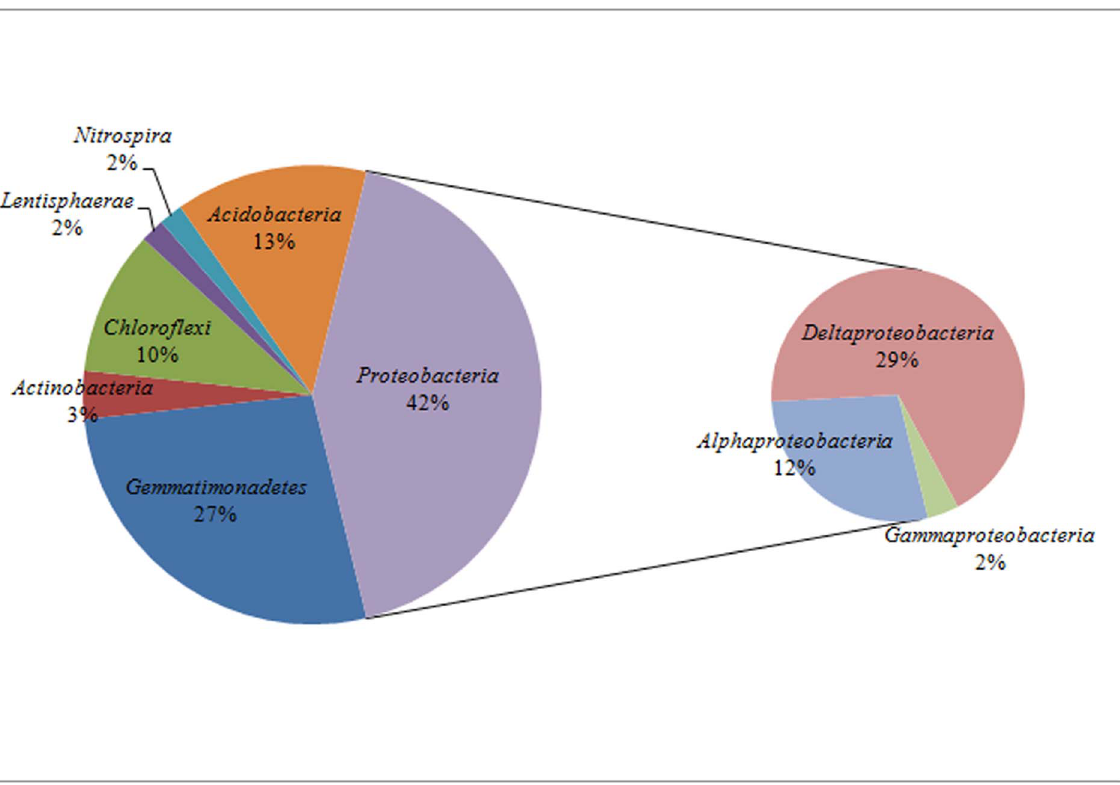
Figure 5. Pie charts illustrating the bacterial community based on 16S rRNA gene libraries of sponge X.testudinaria . Sequences in libraries were classified using the Classifier Tool provided by the Ribosomal Database Project. Hierarchical taxa assignment was based on RDP naive Bayesian rRNA Classifier. Percentage represented specific value between the number of clones in each taxon and the number of all clones in 16S rRNA gene library.